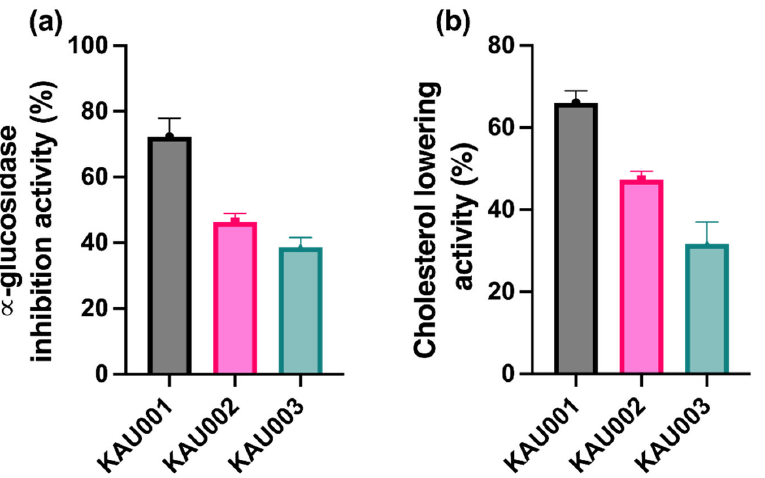
Figure 5. Effect of LAB isolates on ( a ) α‐ glucosidase inhibition activity and ( b ) cholesterol lowering activity. Data are expressed as mean ±S.D. from three independent experiments.